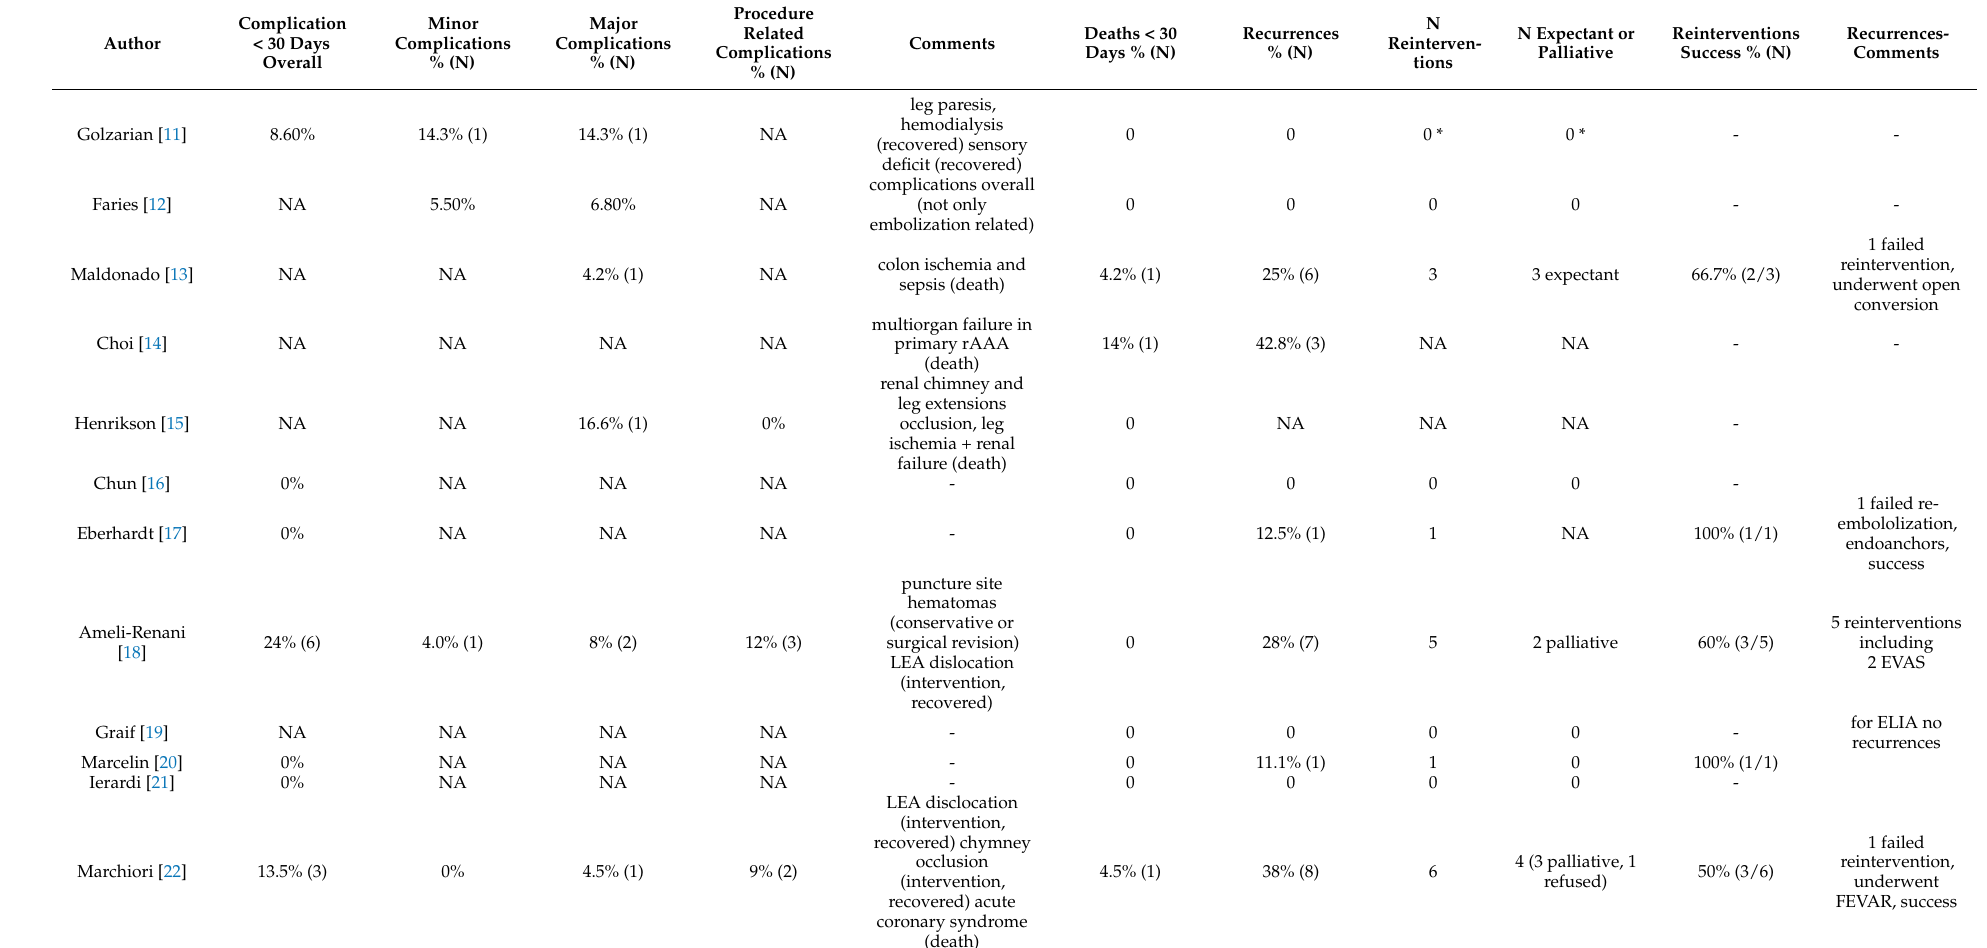
Table 5. Case series: post-procedural events, complications, recurrences and